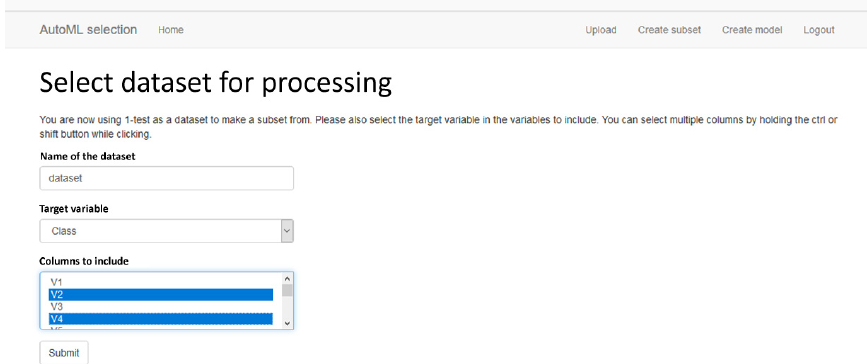
Figure C2. Screenshot 2 of of AutoML artefact A, the Web application interface (preference: GUI).